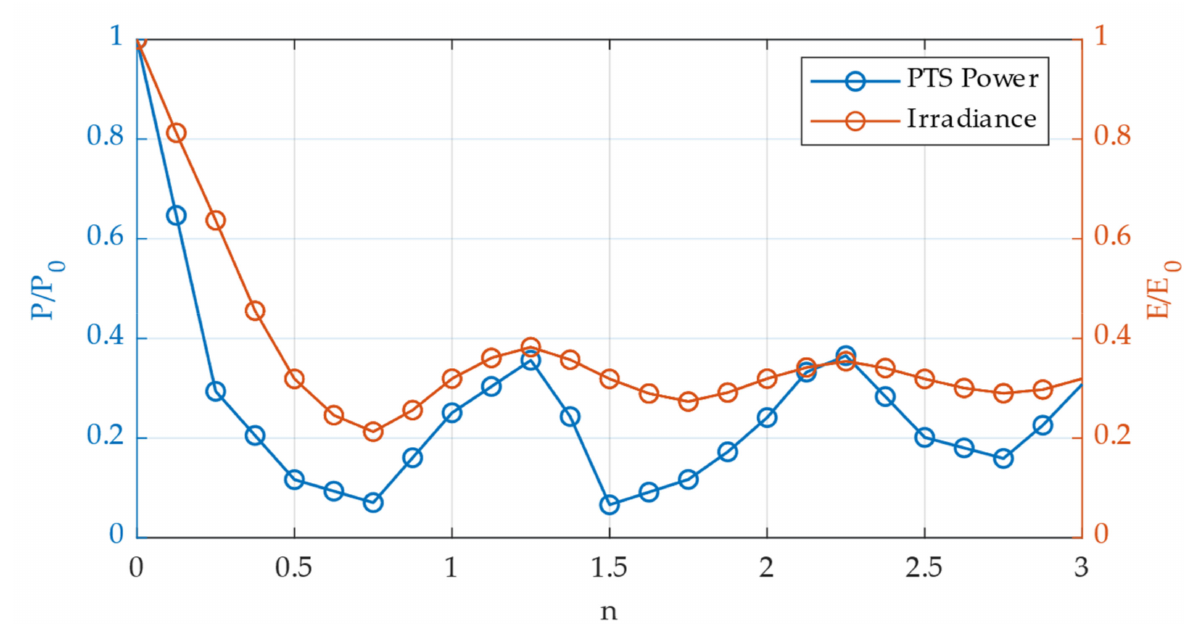
Figure 18. Comparison of the normalized maximum power P/P 0 of the 1.5 m PTS in comparison to the normalized integral of irradiance E/E 0 , received by the PTS, depending on the number of torsional twists